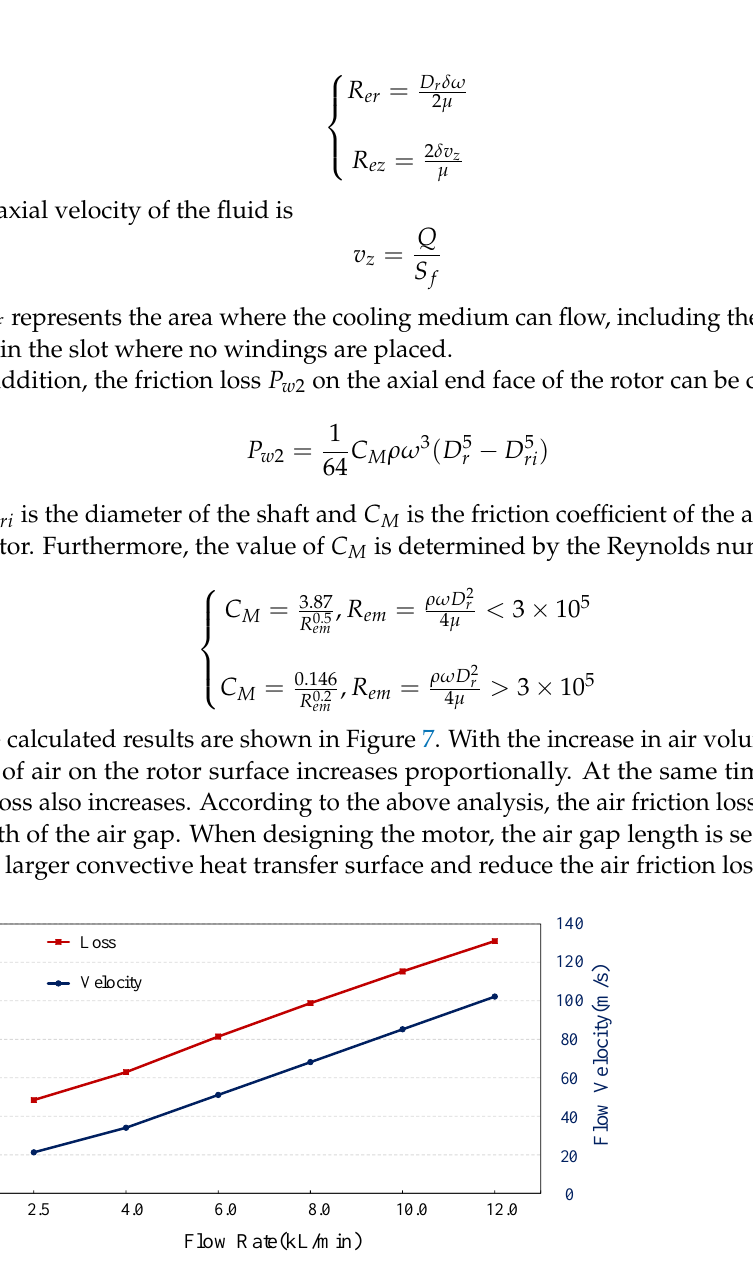
Figure 7. Air friction loss and velocity curve at different flow